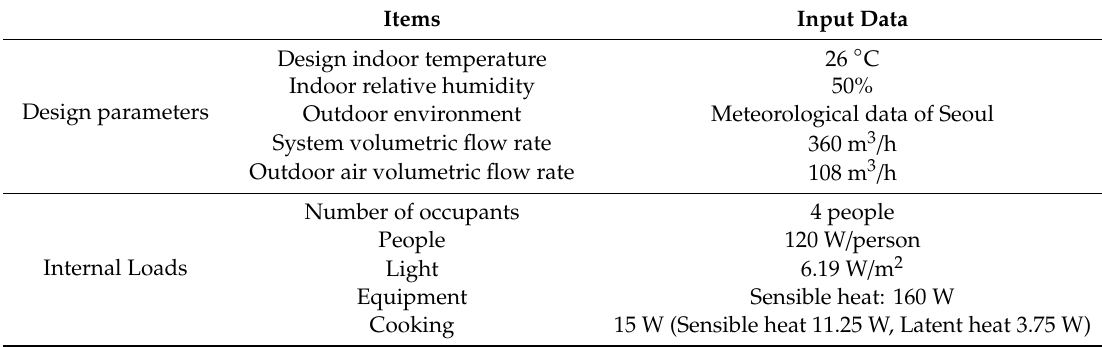
Figure 4. Floor plan of the selected dwelling. Table 1. Summary of input data for simulation.